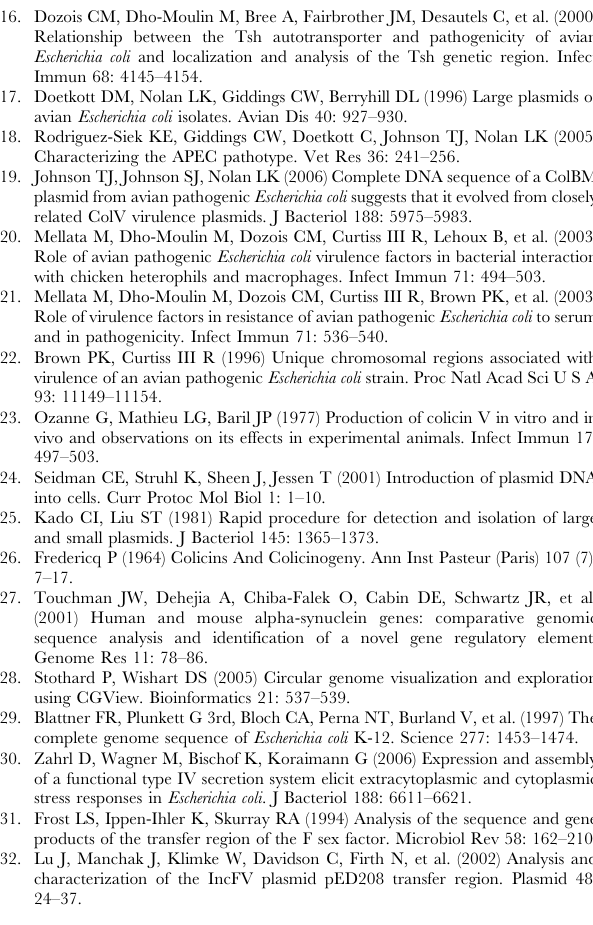
Table S3 ORFs involved in pAPEC-1 plasmid functions. In this table, we present all ORFs involved in pAPEC-1 plasmid functions, including replication, partition and stability. Table S4 Insertion sequences identified in pAPEC-1. In this table, we present details of all insertion sequences identified in pAPEC-1